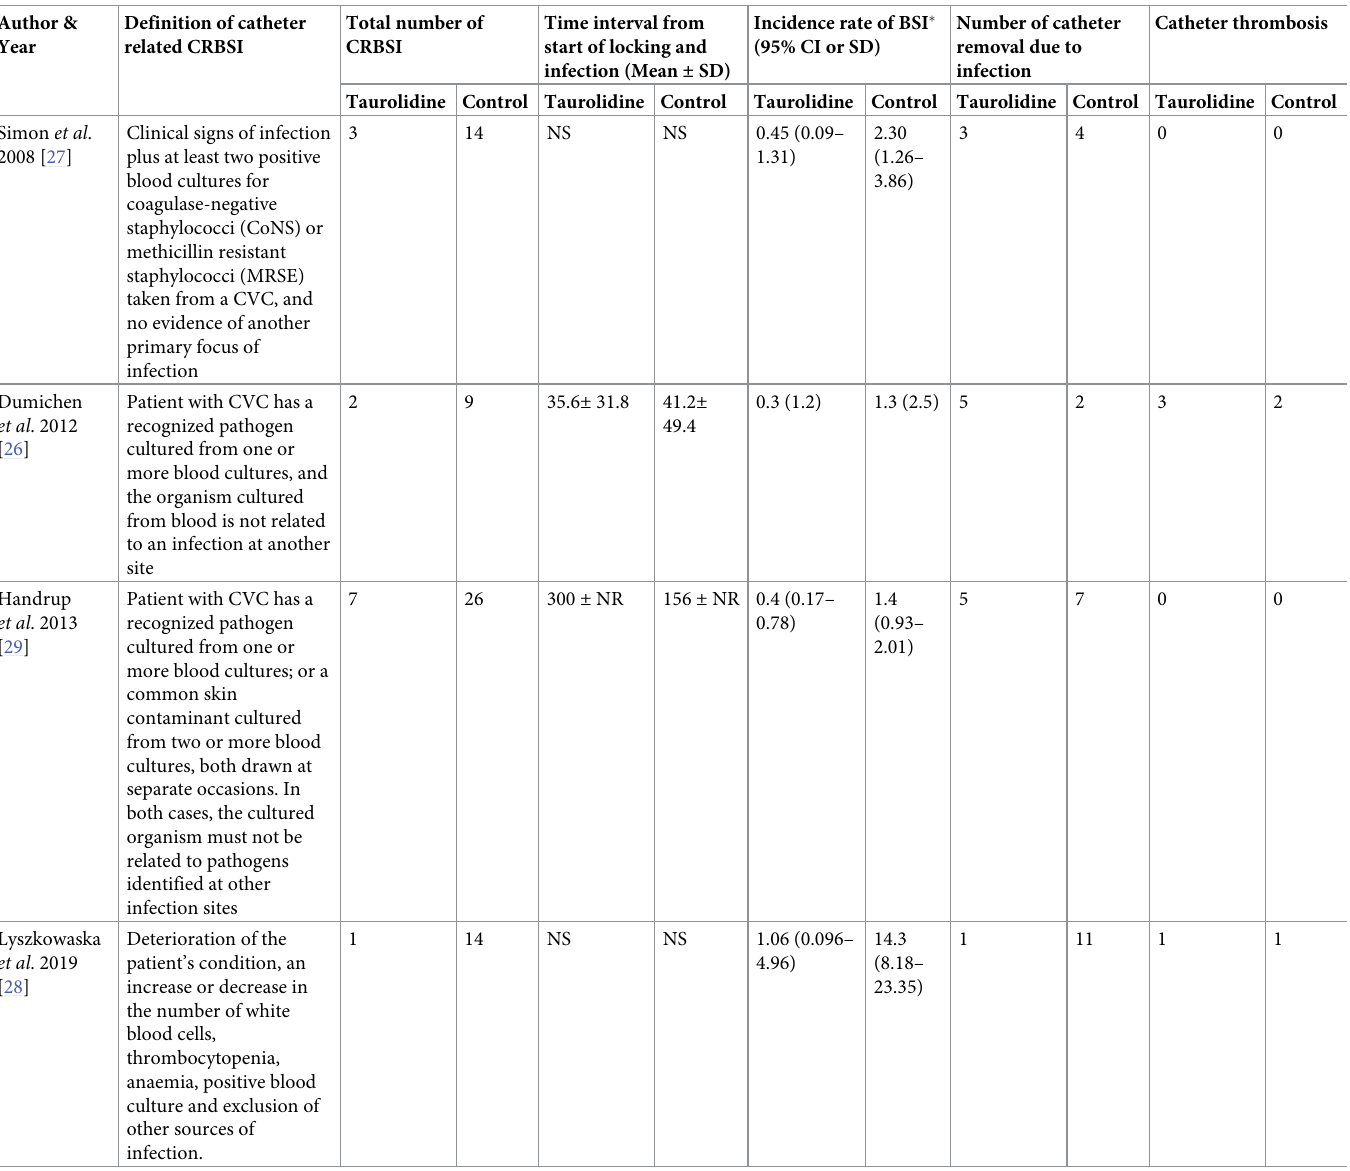
Fig 2. Risk of bias summary of included studies. Red circle denotes a high risk of bias, Yellow circle denotes an unclear risk of bias and green circle denotes a low risk of bias.